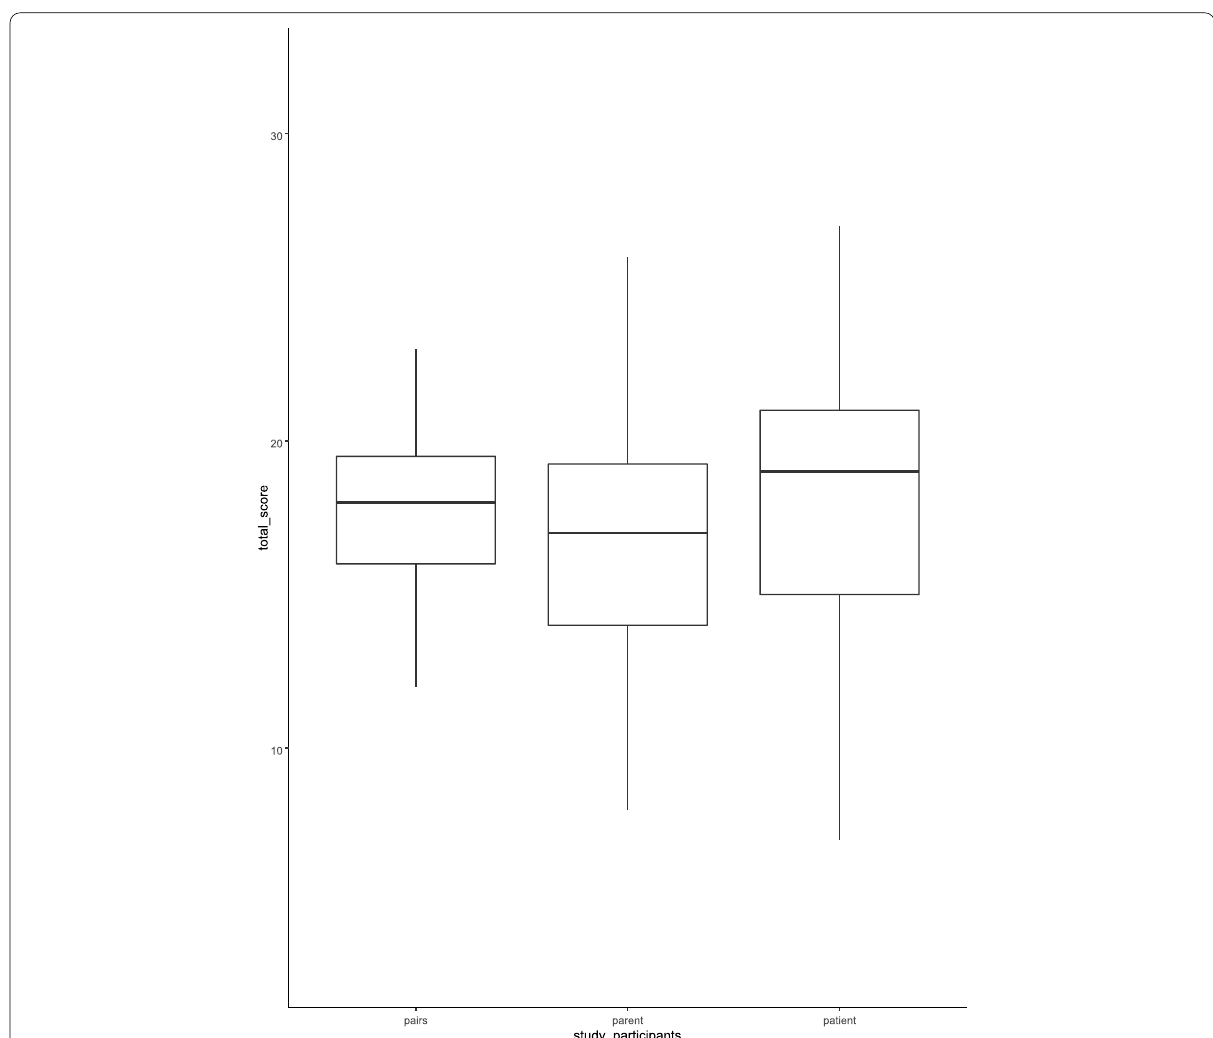
Fig. 1 Overall scores range, median, and interquartile range in the 3 groups. This boxplot was created using ggplot graphic package for R